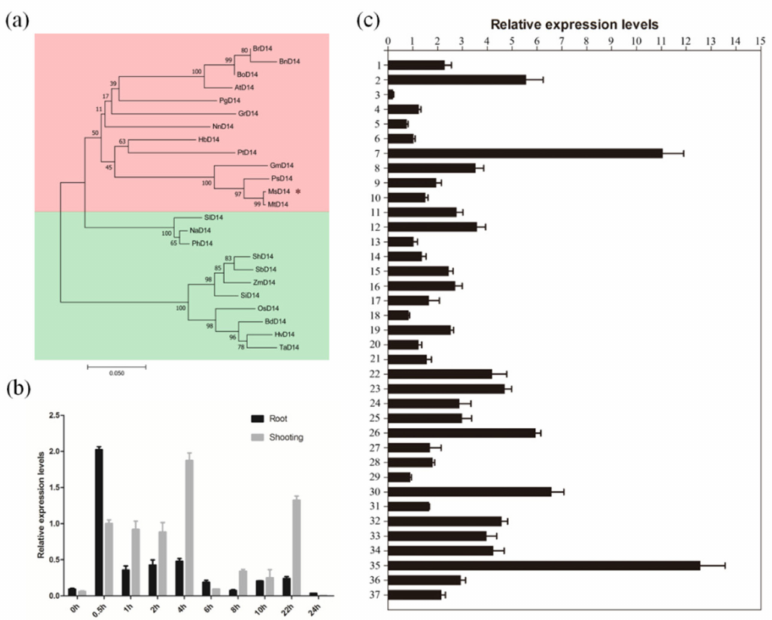
Figure 1. Characterization of MsD14 . ( a ) Phylogenetic analysis of MsD14 among plants. The accession number of D14 protein used for phylogenetic analysis is listed as follows. BrD14: Brassica